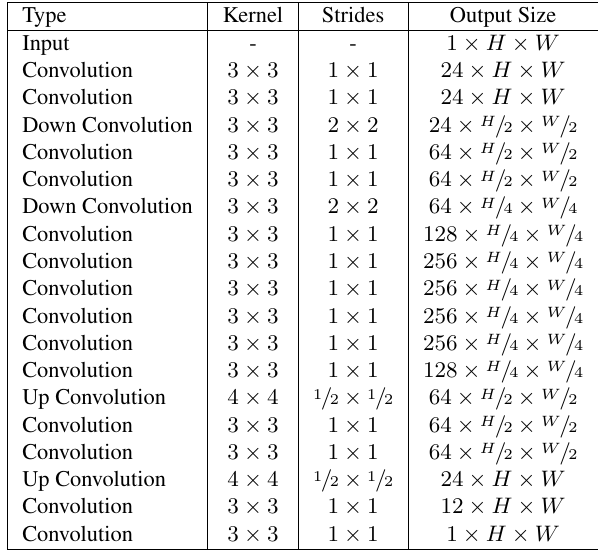
Table 1. Model architecture for our building generalization